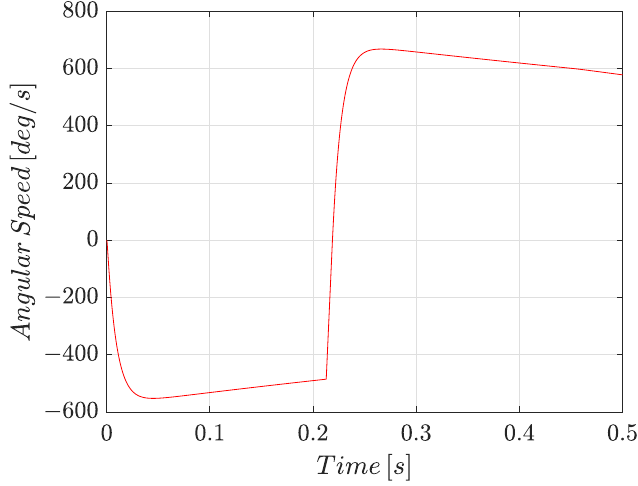
Figure 11. Graph showing that the system works under stick conditions only two times during the whole